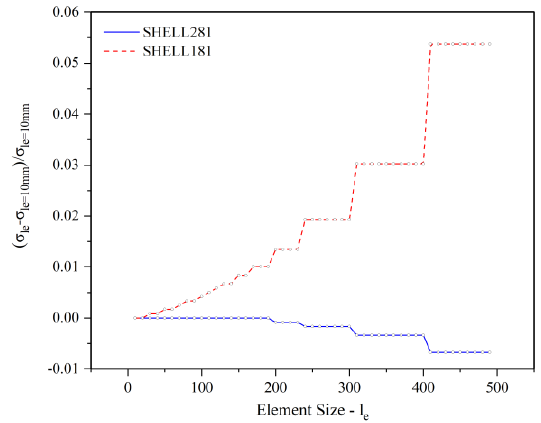
Figure 6. Mesh convergence for 4-node and 8-node elements.